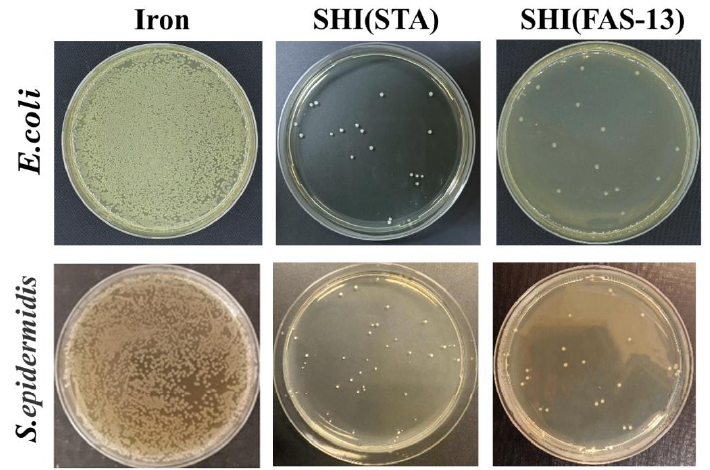
Figure 8. E. coli and S. epidermidis on ordinary iron (Iron), and superhydrophobic iron samples of SHI (STA) and SHI